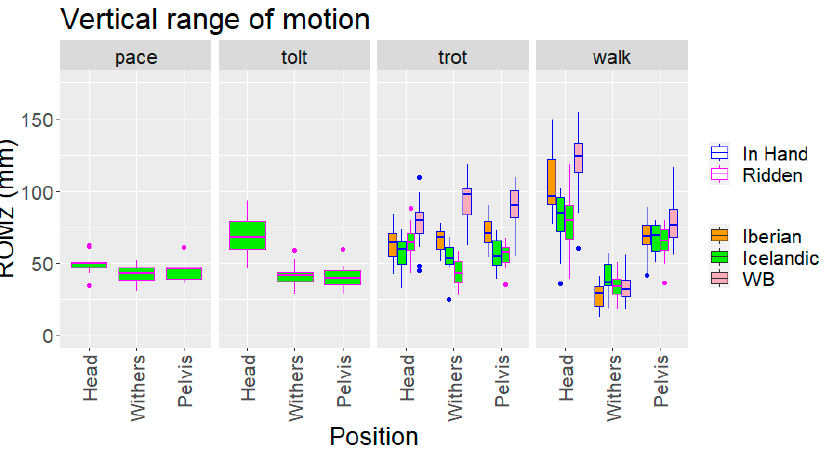
Figure 2. Vertical range of motion (ROMz) of upper body segments for different gaits, breeds and conditions (ridden vs. in hand). WB: Warmblood horses.